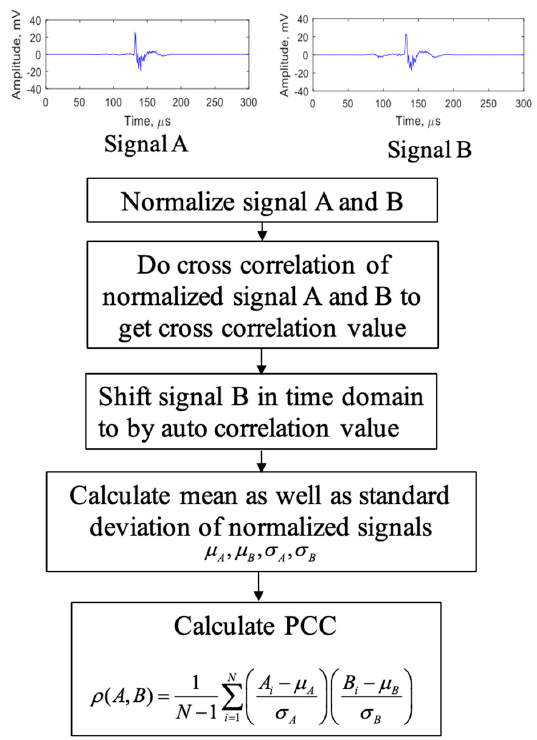
Figure 19. Procedure for obtaining the Pearson correlation coefficient of two time–domain